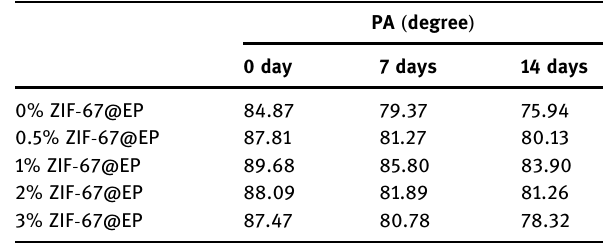
Table A3: Bode impedance values of composite coatings at di ff erent immersion times